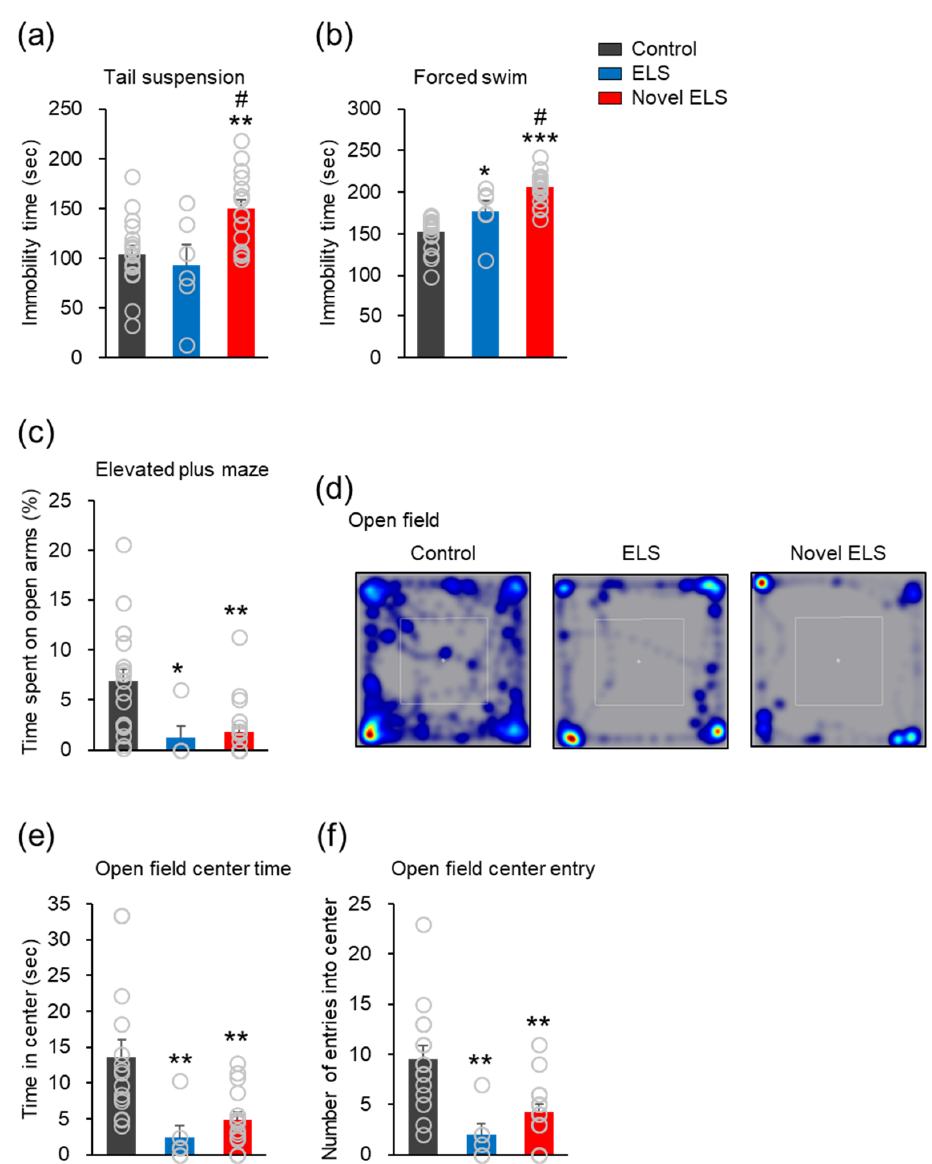
Figure 1. Novel ELS model provokes anxiety- and depression-like behavior in the offspring mice. ( a ) Tail suspension test. ( b ) Forced swimming test. Statistical significance was determined using one-way ANOVA, with Bonferroni’s correction. * p < 0.05 and ** p < 0.01 vs. vehicle, *** p < 0.001 vs. vehicle, # p < 0.05 established ELS vs. novel ELS. ( c ) Elevated plus-maze test. Statistical significance was determined using one-way ANOVA, with Bonferroni’s correction. * p < 0.05 and ** p < 0.01 vs. vehicle. ( d ) Representative images of mouse movement in the open-field test. ( e ) Time spent in the center. ( f ) Number of entries into the center. Statistical significance was determined using one-way ANOVA, with Bonferroni’s correction. ** p < 0.01 vs. vehicle. Data represent mean ± SEM.